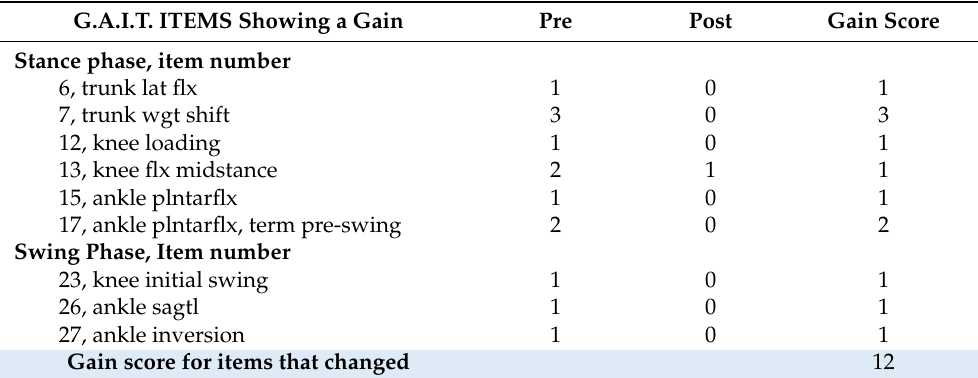
Table 2. Gait Assessment and Intervention Tool (G.A.I.T.), Measuring Gait